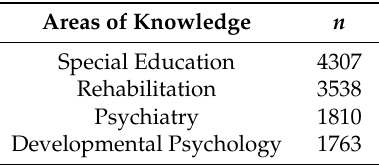
Table 3. Areas of knowledge.